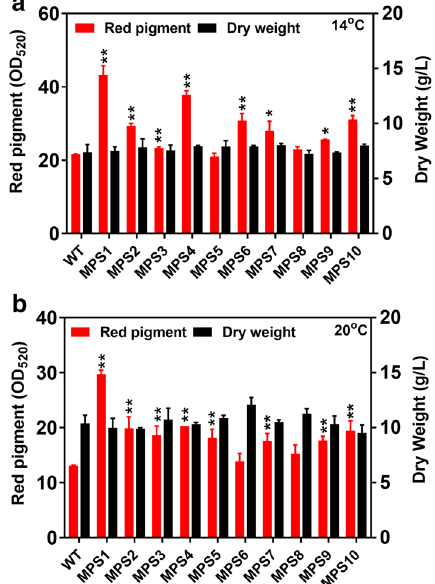
Fig. 2 Red pigment production and cell growth of MPS1–MPS10 mutants obtained by single transposable systems. a The red pigment production and its dry weight of the mutants at 14 °C. b The red pigment production and its dry weight the mutants at 20 °C. The value of the bar represents the highest pigment level or the highest biomass dry weigh at culture duration. Determination of absorbance value of red pigment at wavelength of 520 nm (OD 520 ). Data of significance were shown in ** P < 0.01 and * P <